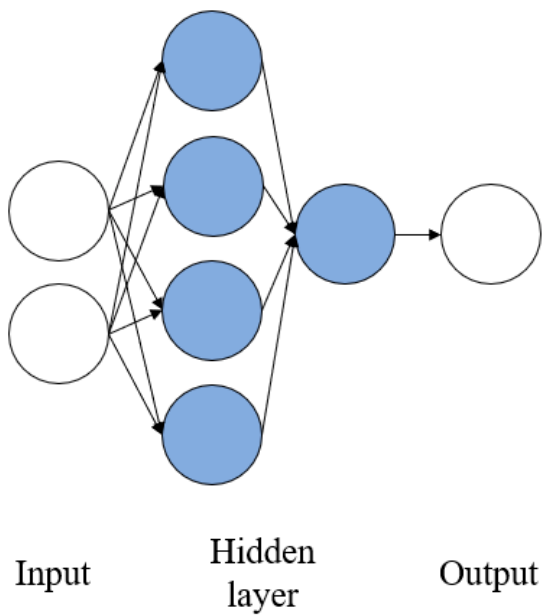
Figure 3. ANN structure for two input parameters (P1 + P2, P1 + P3 and P2 + P3). The last model was the combination of all three input parameters. Two hidden layers were used, with the first hidden layer using nine neurons as a rule of thumb of the hidden layer as the input layer square, and the second layer used 1 neuron. The first layer used tansig as a transfer function, and the second layer used purelin as a transfer function.